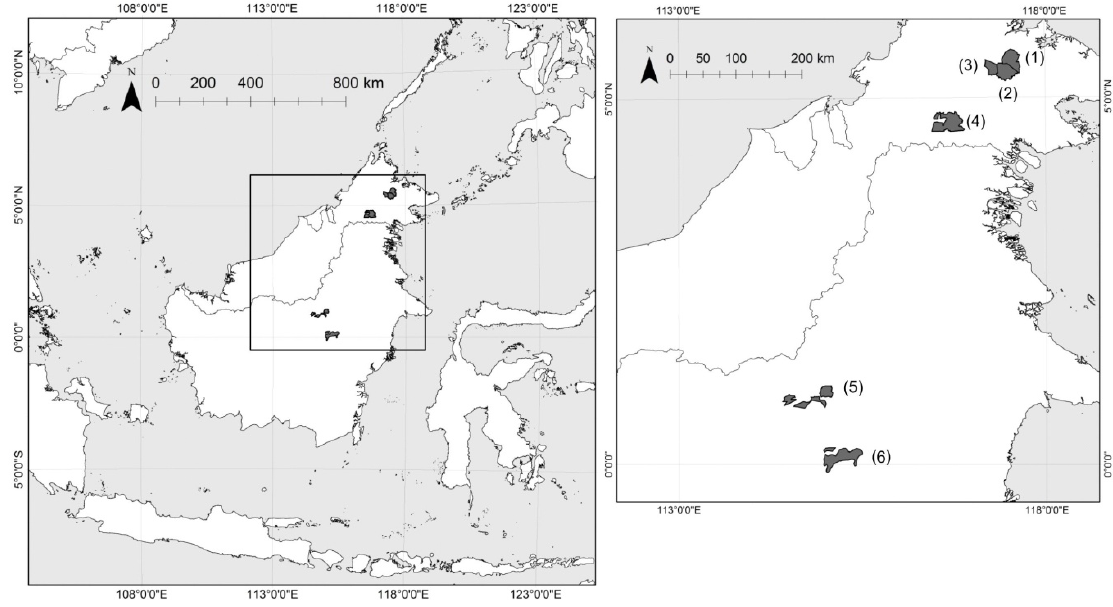
Figure 1. Locations of the six forest management units (FMUs) in this study: (1) Segaliud Lokan, (2) Deramakot, (3) Tangkulap, (4) Sapulut, (5) Roda Mas, and (6) Ratah. Table 1. Profiles of the forest management units (FMUs) targeted in this study.